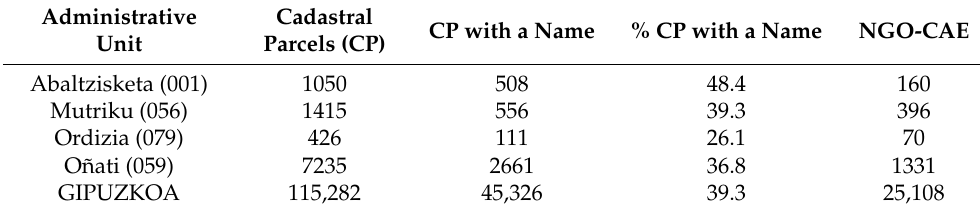
Table 1. Number of elements stored in the databases under analysis.